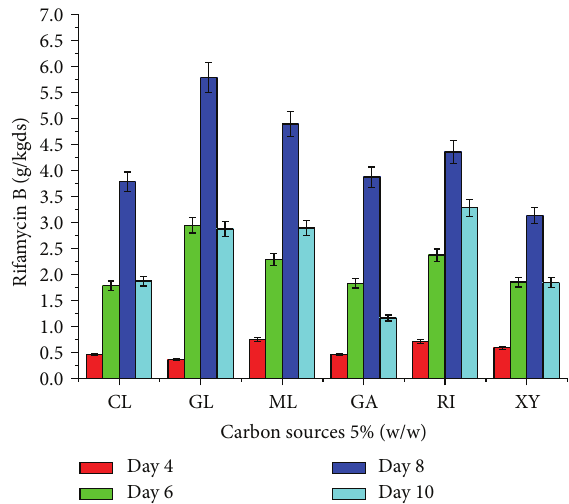
Figure 1: Effect of various carbon sources (5% w/w) on rifamycin B production by Nocardia mediterranei MTCC 14 using sunflower oil cake under solid-state fermentation. Cl: control, GL: glucose, Ml: maltose, Ga: galactose, RI: ribose, and XY: